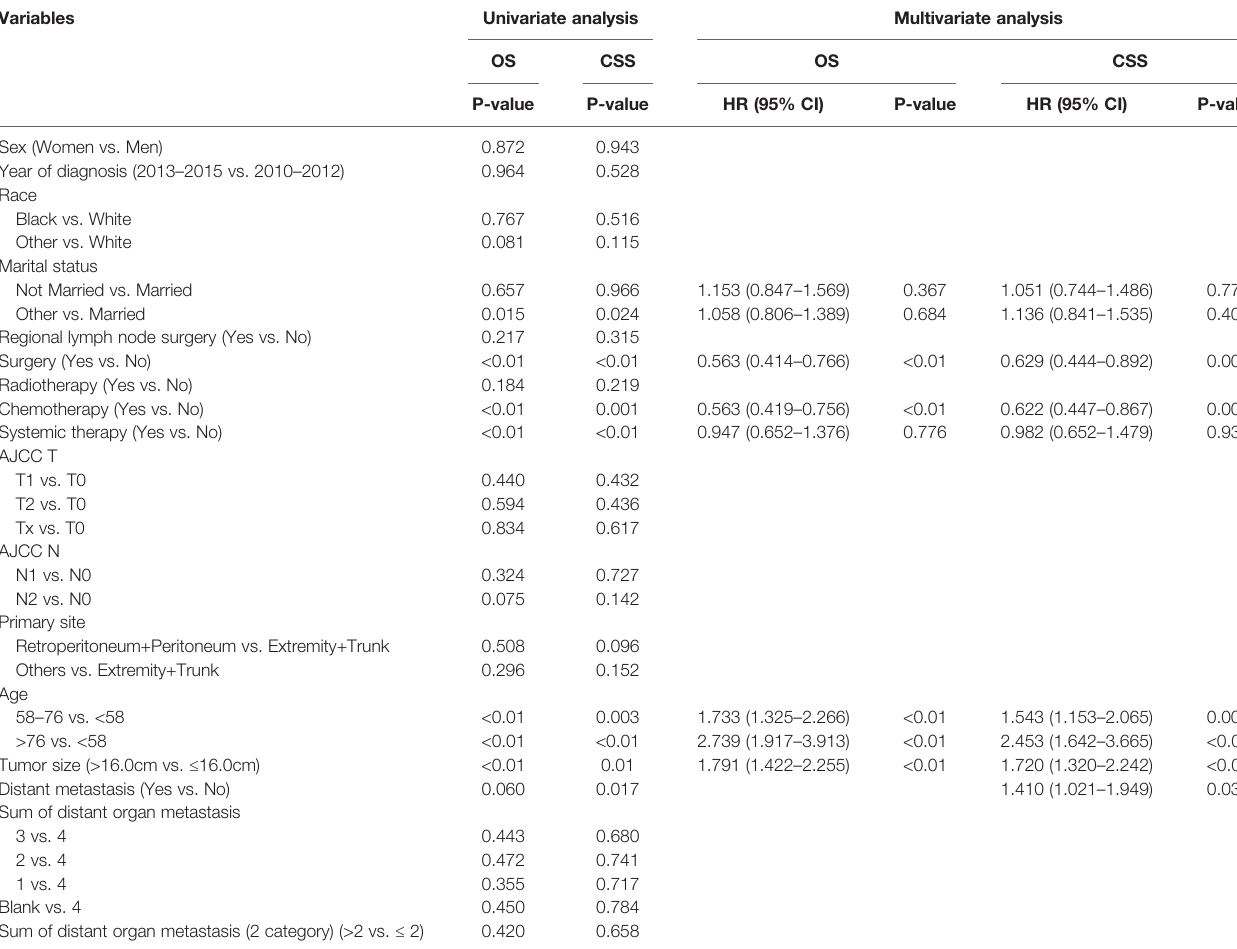
TABLE 3 | Univariate and multivariate Cox proportional hazards regression analyses for OS and CSS in the training dataset.